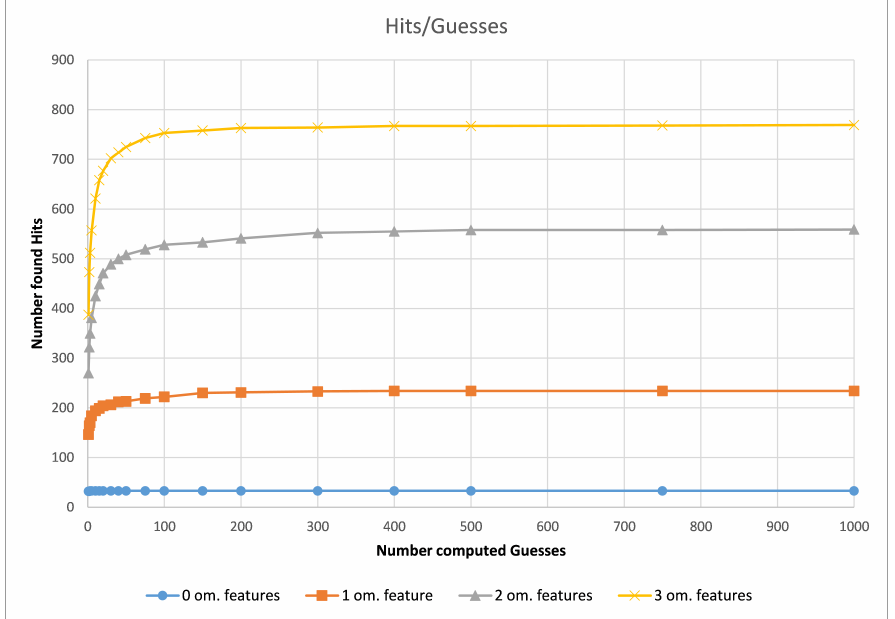
Figure 6. CDK2, number of hits vs. computed